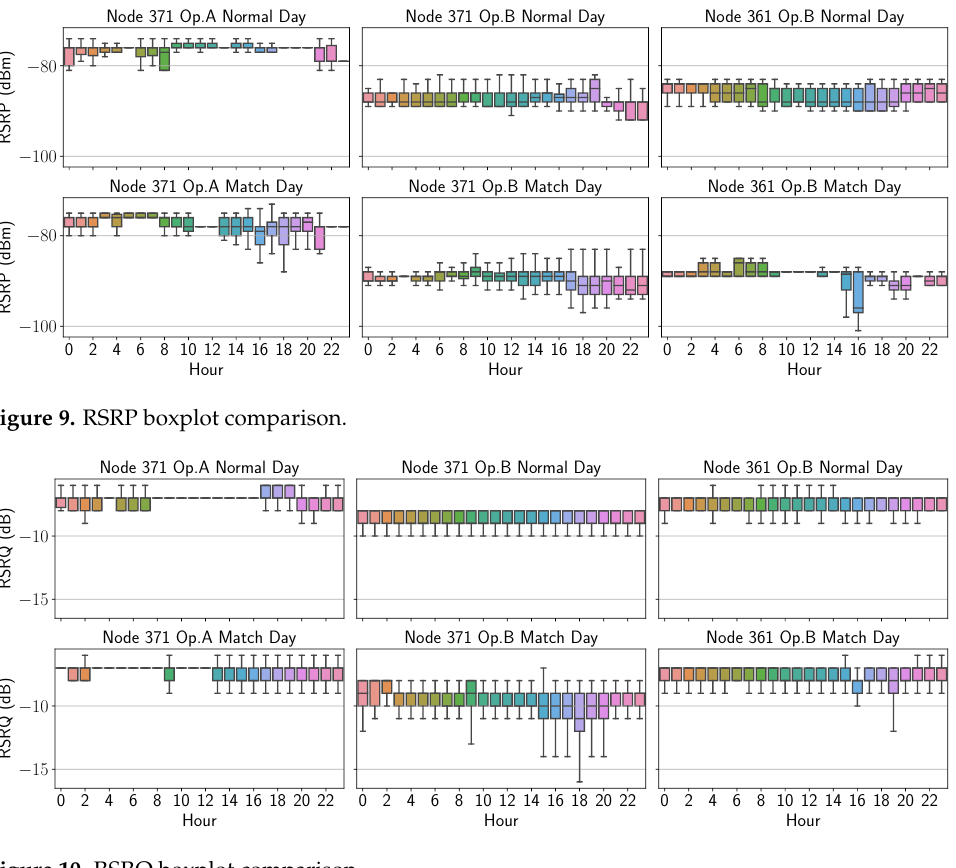
Figure 10. RSRQ boxplot